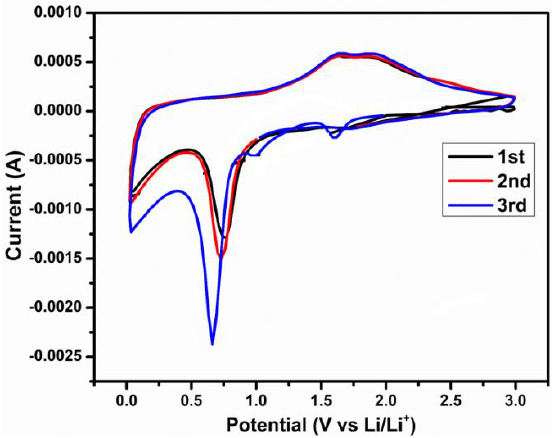
Figure 7. Cyclic Voltammograms of the Fe 3 O 4 /RGO composite electrode at a scan rate of 0.1